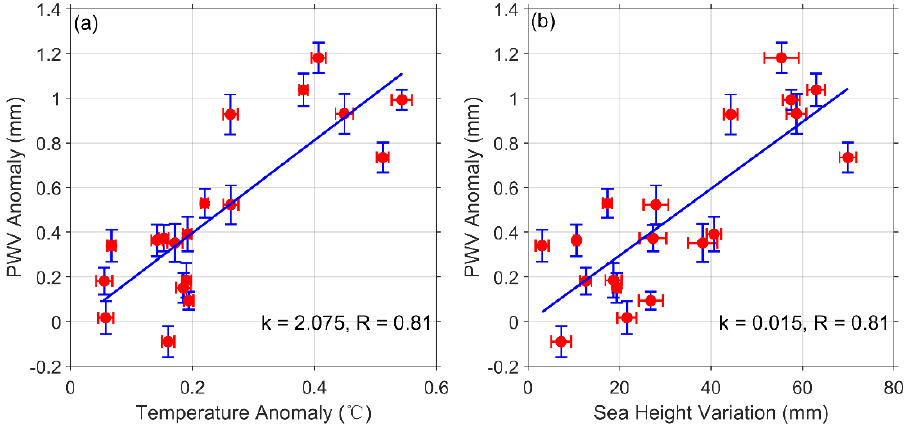
Figure 12. Comparison of PWV anomalies with temperature anomalies ( a ) and sea height variations ( b ). The red dots are the annual averages, the red error bars are the yearly fluctuations in temperature anomalies and sea height variations, and the blue error bars are the yearly fluctuations in PWV anomalies. k represents the slope of the linear fit, and R represents the correlation coefficient.